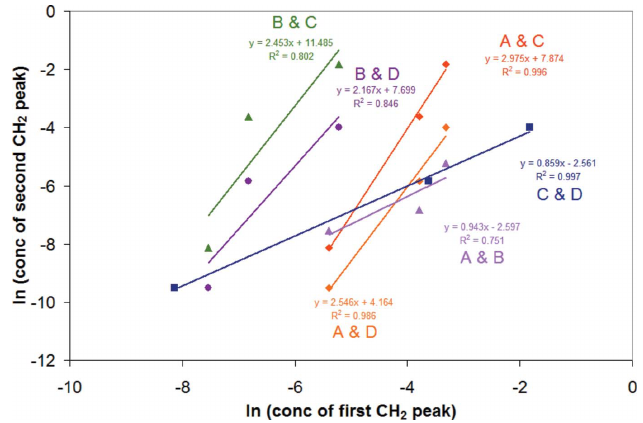
Figure 6 ln–ln plots of the concentrations of the molecules represented by the CH 2 —Al peaks in the proton spectra. The concentration is calculated from the integral fraction of those CH 2 resonances multiplied by the total concentration of CH 2 (AlBr 2 OEt 2 ) 2 dissolved. The slope of the line is the ratio of the degree of association of the species in solution.